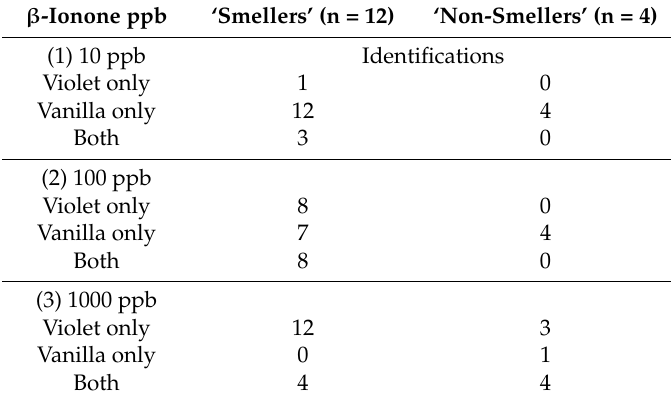
Table 2. Responses of β -ionone (‘violet odor’) smellers and β -ionone non-smellers to mixtures with 10 ppm vanillin (‘vanilla odor’).